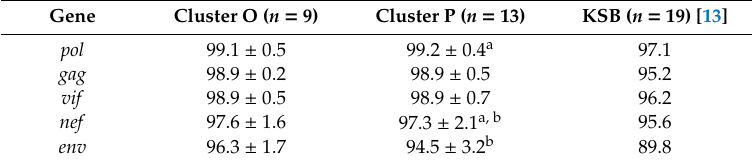
Table 4. Comparison of sequence identity with donors O and P within each